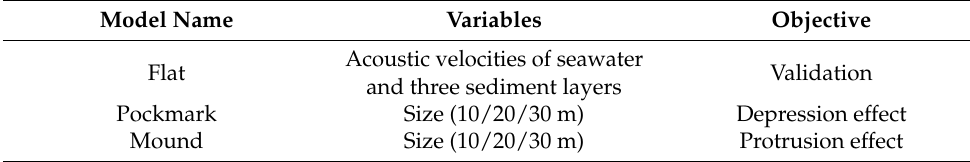
Table 1. Tested input models for morphological variations.